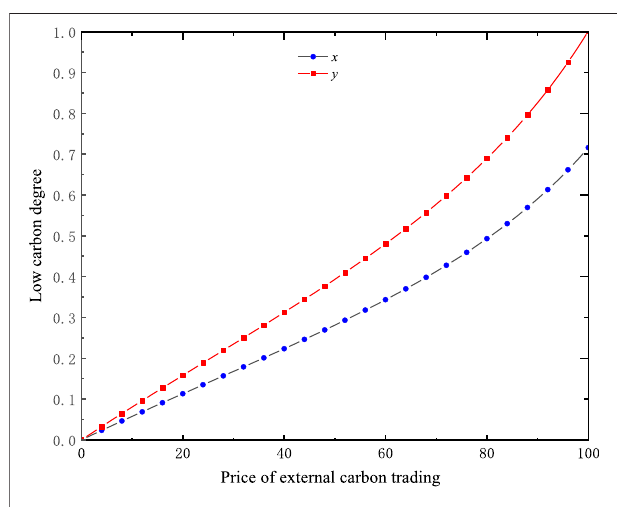
FIGURE 1 | The impact of external carbon trading prices on the degree of low